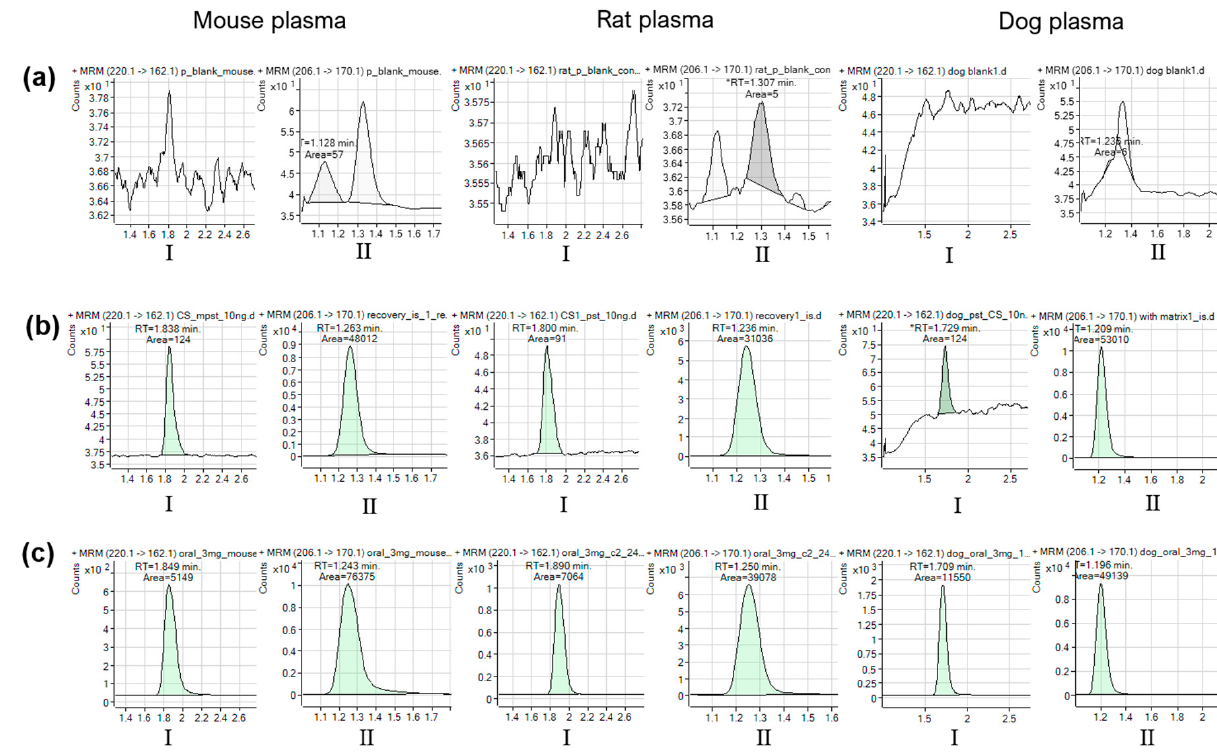
Figure 3. Representative multiple reaction monitoring (MRM) chromatograms of DA-7010 (I) and the IS (II) in each mouse, rat, and dog plasma sample: ( a ) blank plasma; ( b ) blank plasma spiked with lower limit of quantification (LLOQ) level of DA-7010 (10 ng/mL) or mixed with the IS at working concentrations (10 µ g/mL); ( c ) plasma samples collected 4 h after oral administration of 3 mg/kg DA-7010 to mouse, rat, and dog with determined DA-7010 concentrations of 334, 648, and 1952 ng/mL, respectively.